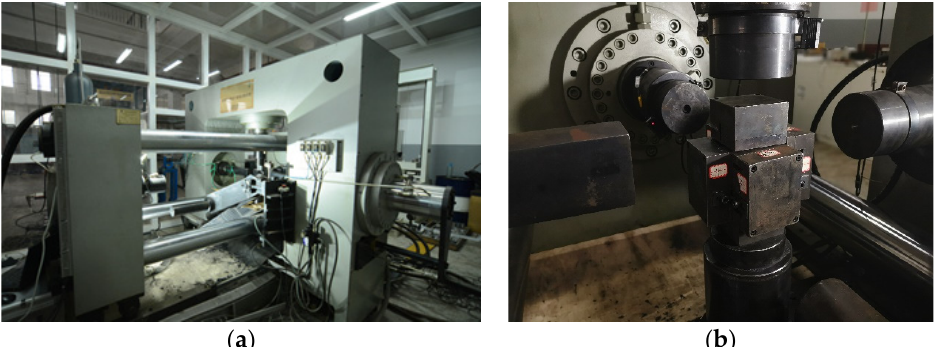
Figure 1. True triaxial coal-rock dynamic behavior testing system: ( a ) schematic diagram of equip- ment; ( b ) single face unloading part with a droppable loading bar.